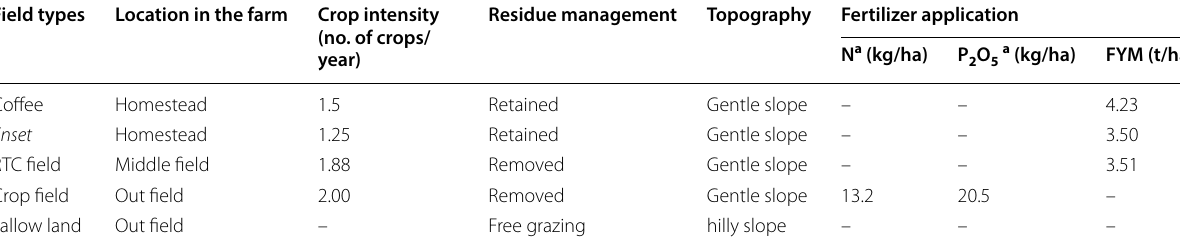
a Source of fertilizer is urea (46-0-0) and Di-ammonium Phosphate (18-46-0), respectively